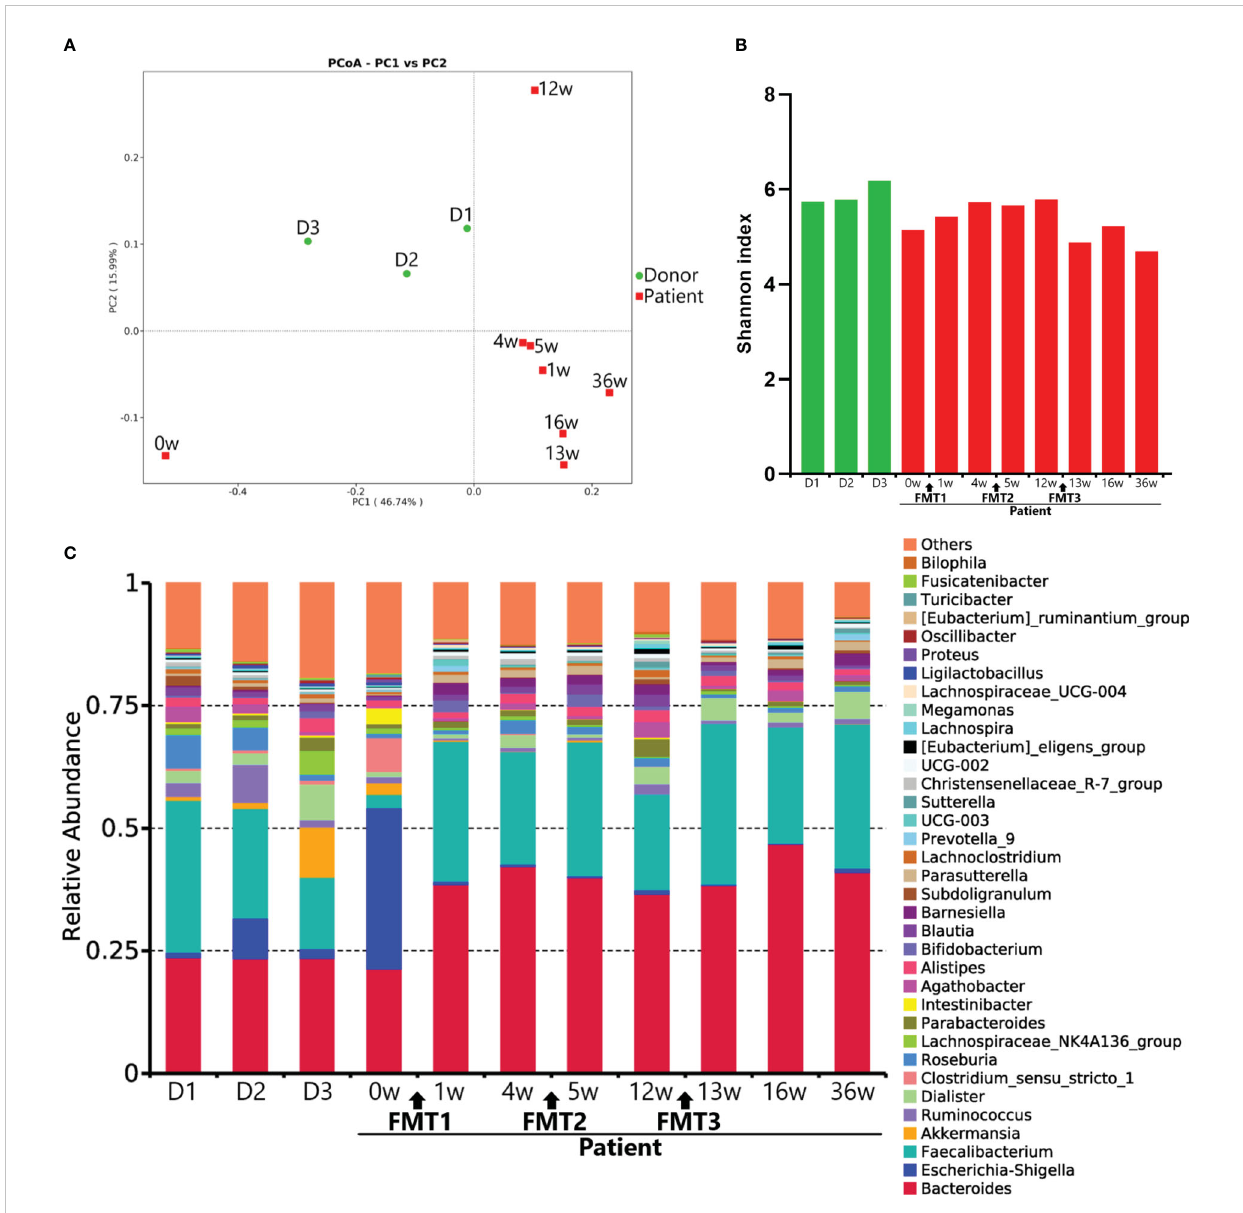
FIGURE 3 Microbial pro fi les. (A) Principal coordinate analysis of the taxonomy pro fi le. (B) Shannon index of the gut microbiota. (C) Taxonomy at the genus level. D1 – D3 represent the microbial pro fi les of donors for FMT1 –